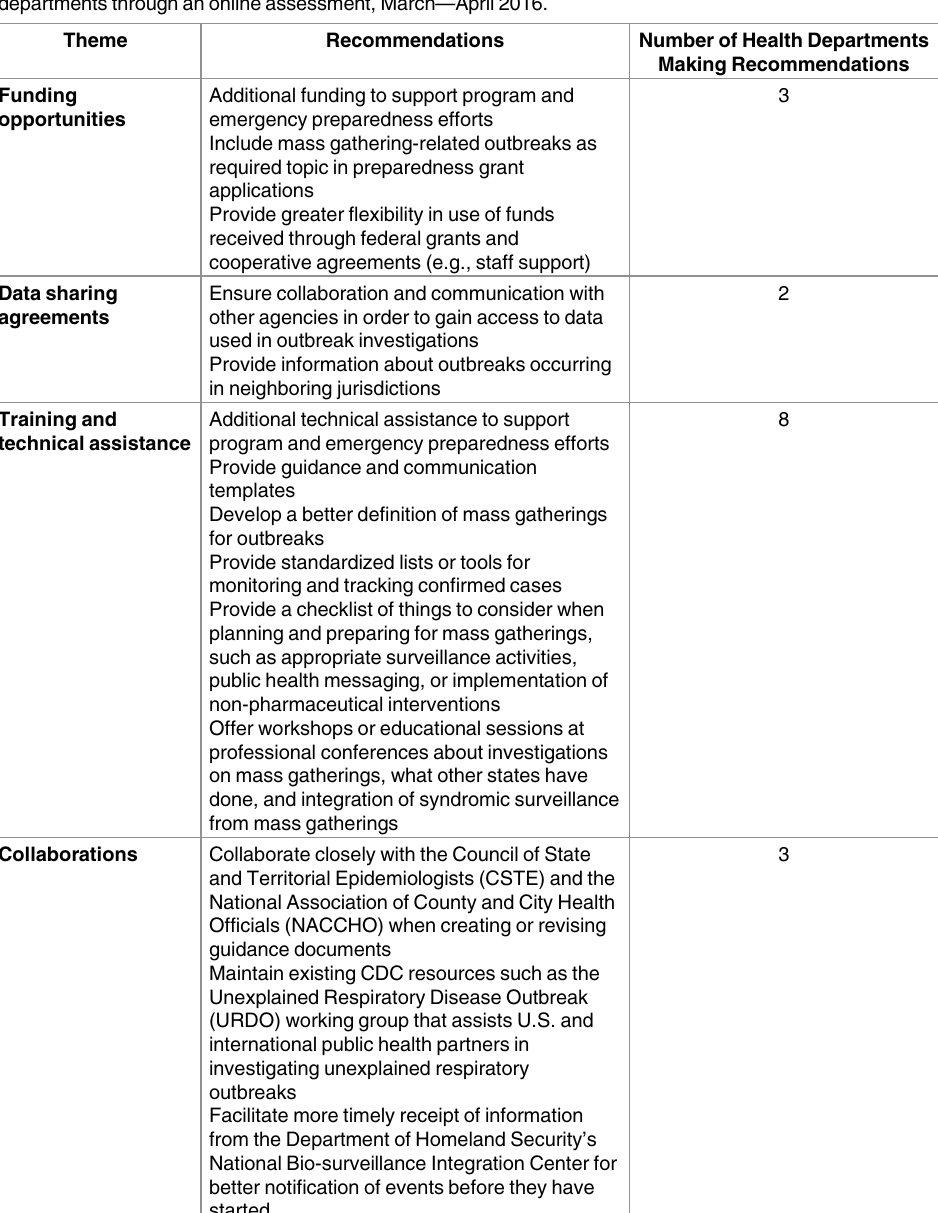
Table 5. Health departments’ recommendations to the Centers for DiseaseControl and Prevention to help improve pandemic preparedness, communication approaches, and use of nonpharmaceutical interventions at mass gatherings, using four common themes. Providedby 14 state and local health departments through an onlineassessment, March—April